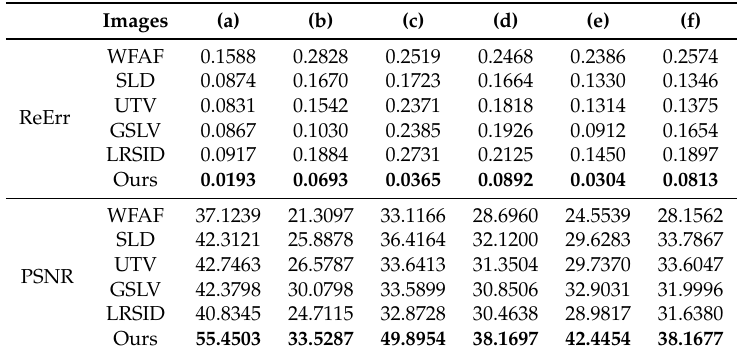
Table 1. The ReErr results between s added and s estimated , and the PSNR between the ground-truth and the computed image by the different